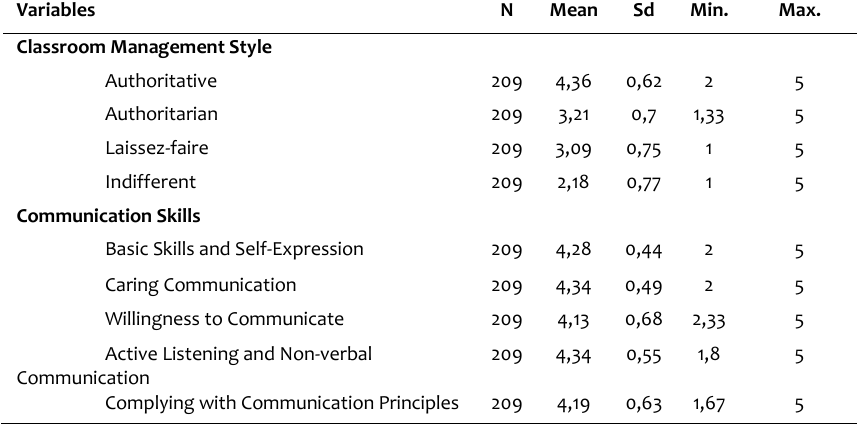
Table 2. Statistics about teachers’ classroom management styles and communication skills Variables